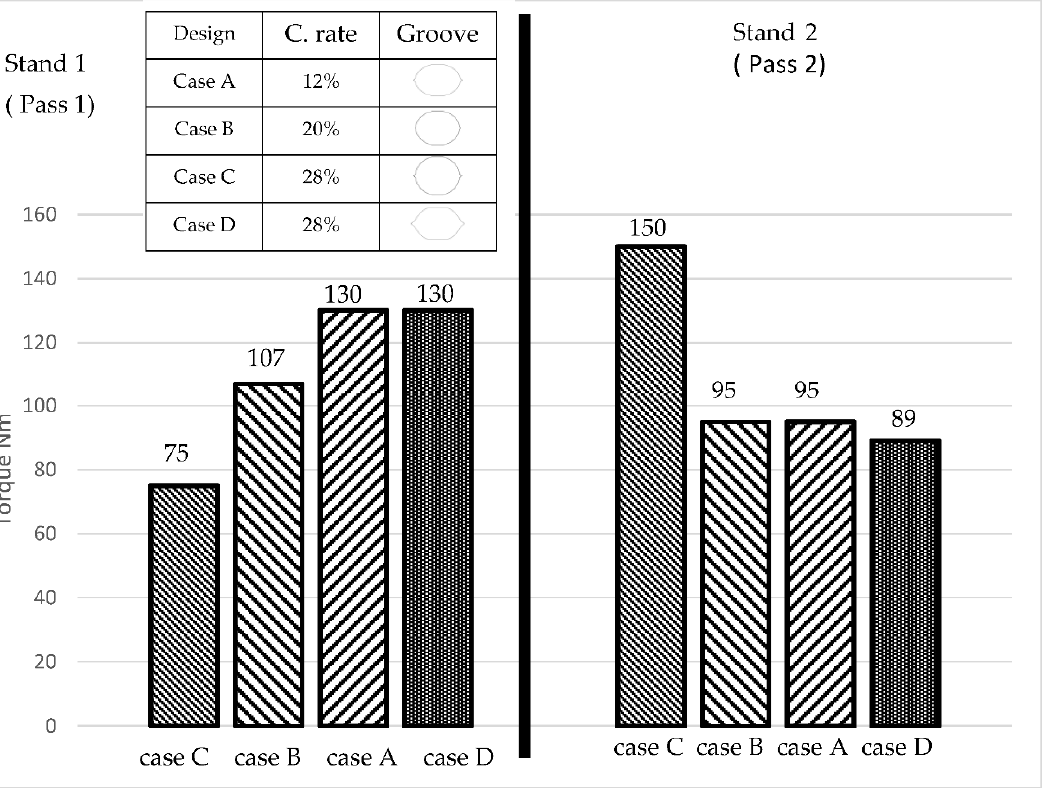
Figure 11. Rolling torques of passes 1 and 2 for different compression rates (C. rate) at pass 1.